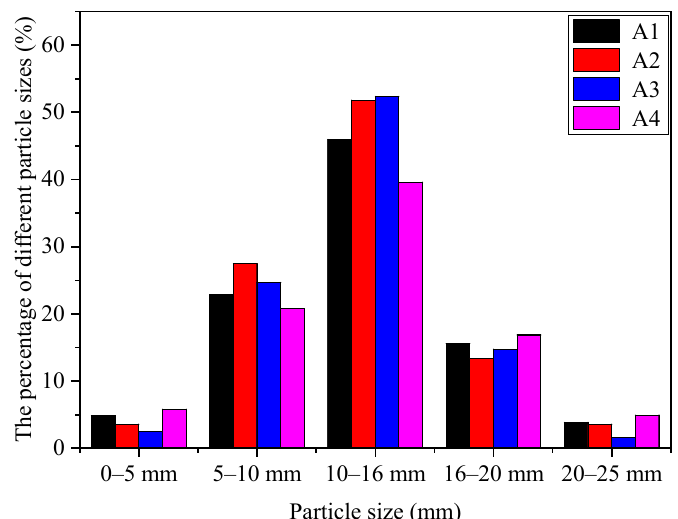
Figure 6. Particle size distribution of RM-based SFLAs.